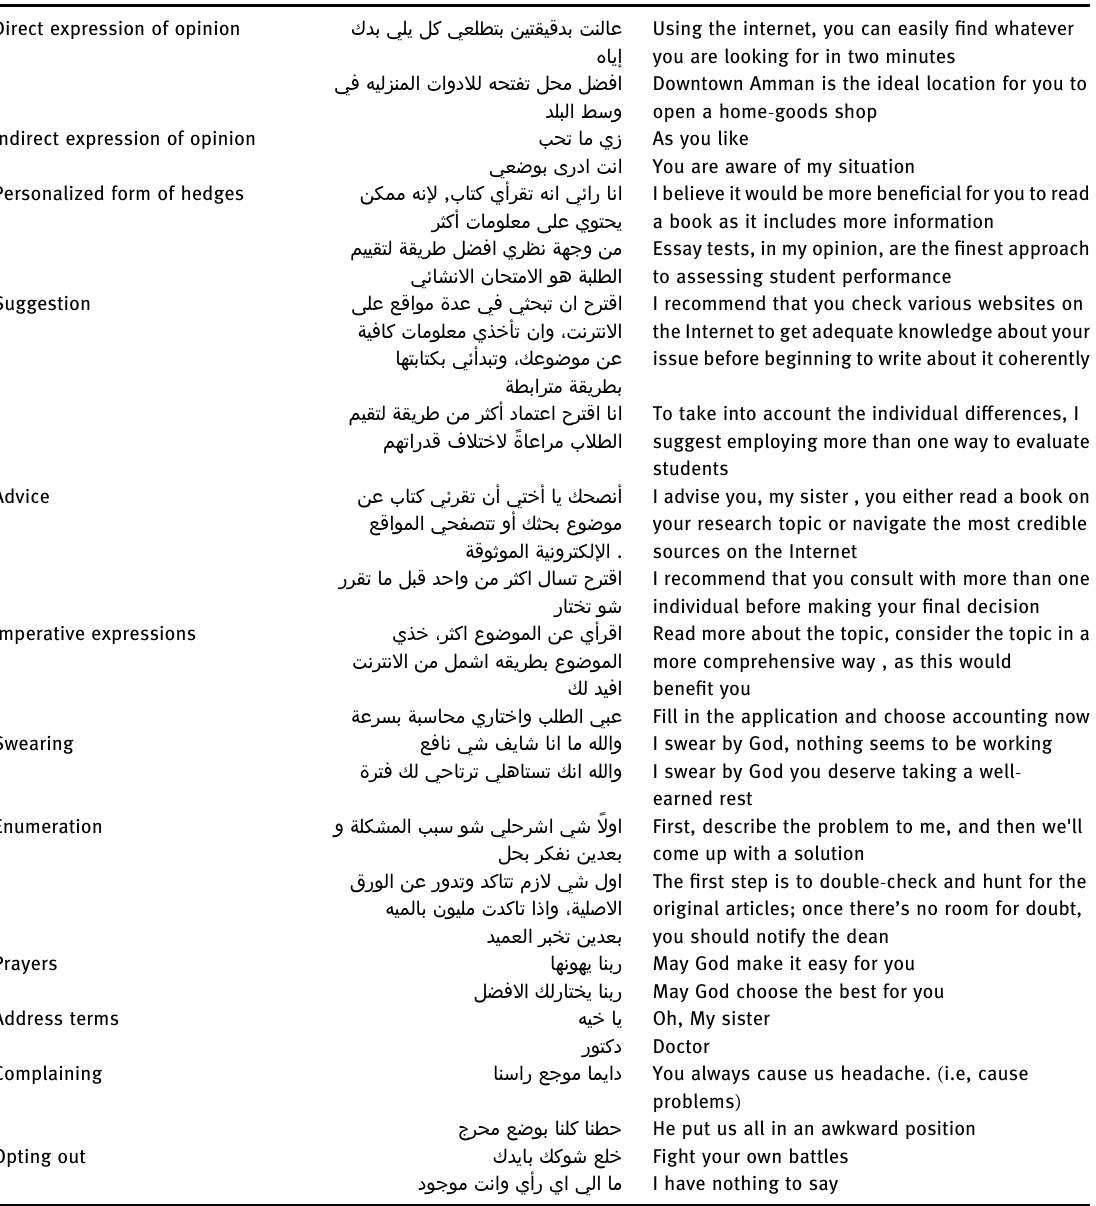
Table A1: Illustration of strategies used for expressing opinion among speakers of JA along with examples and their translation